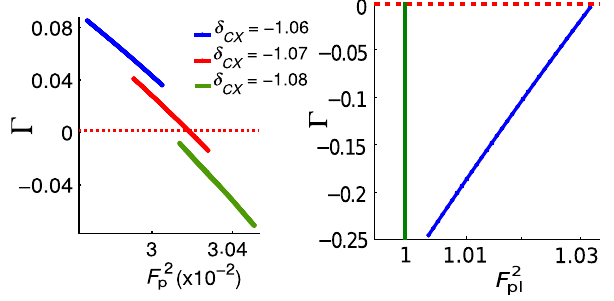
FIG. 4. Changing the effective anisotropy by tuning the driving strength. Left panel: Anisotropy parameter Γ as a function of (in the same range as region A in Fig. 2) for pump power F 2 p − 1 . 06 (blue line), − 1 . 07 (red line), different detunings δ CX ¼ − 1 . 08 (green line) in the stable three-mode OPO regime. − 1 . 075 , the anisotropy Parameters are as in Fig. 3. For δ CX ¼ parameter crosses zero (dotted red line). Note that the extent of region A, i.e., the range of pump powers for which the three- mode OPO ansatz is stable, depends on the value of the detuning. Right panel: Anisotropy parameter Γ as a function of normalized ≡ F =F lo pump power, where F , at zero detuning but close to pl p p the lower OPO threshold, indicated by the green vertical line. The ≈ 1 . 84 and k 1 . 0 . pump and signal have large momenta k p s ¼ The dotted red line marks the Γ ¼ 0 line. This case corresponds to region C in Fig.